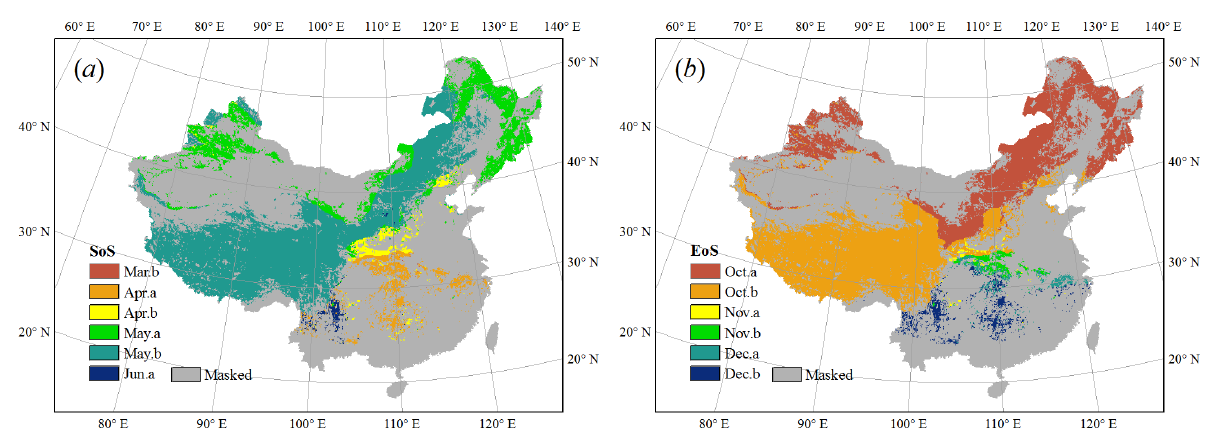
Figure 2. Spatial distribution of the growing season for non-evergreen vegetation in China. ( a ) start of season (SoS); ( b ) end of season (EoS). a and b in the legend denote the first half and the second half of a month